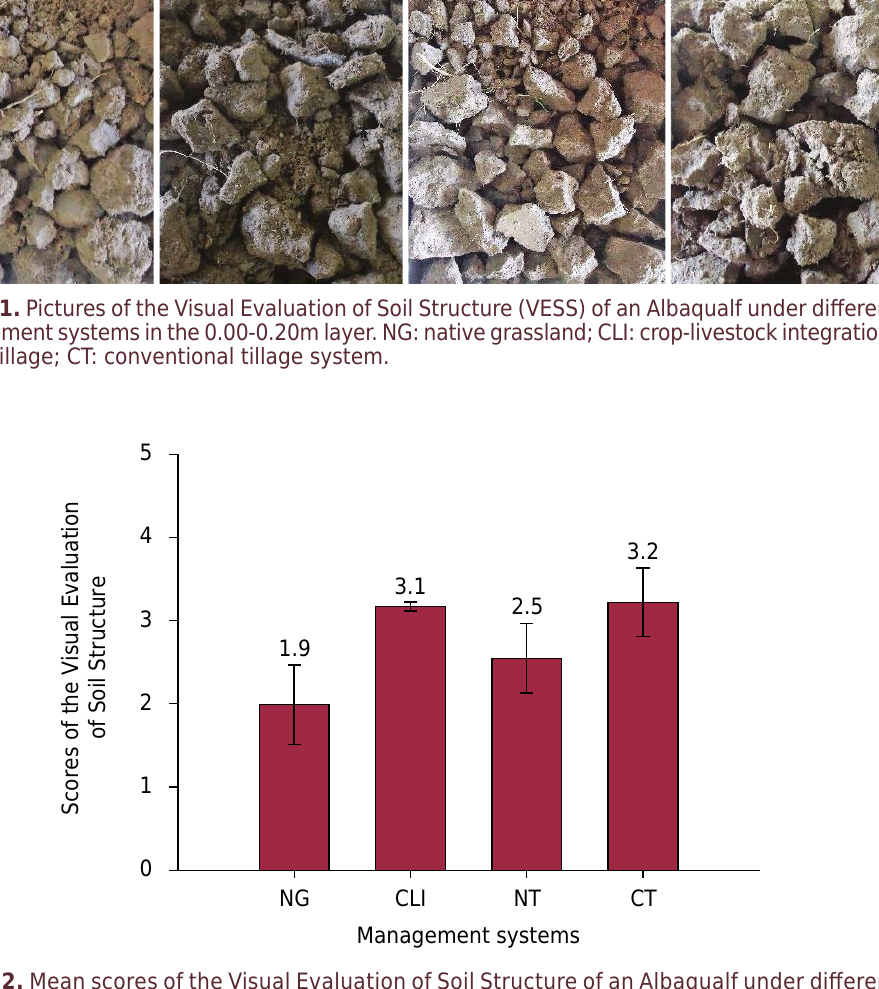
Figure 2. Mean scores of the Visual Evaluation of Soil Structure of an Albaqualf under different management systems in the 0.00-0.20 m layer. NG: native grassland; CLI: crop-livestock integration; NT: no-tillage; CT: conventional tillage system. Vertical bars indicate the standard